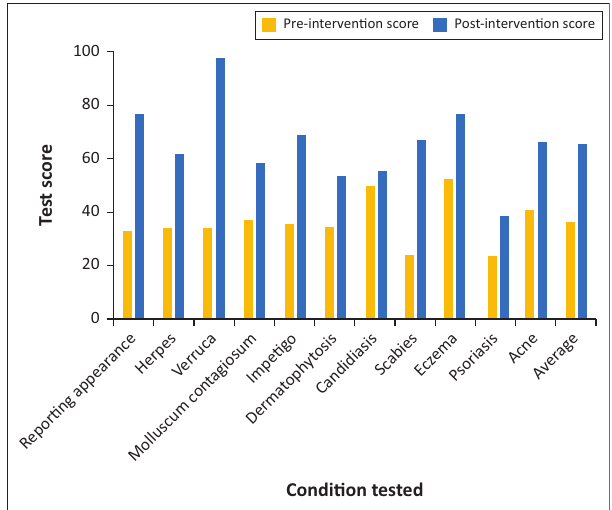
FIGURE 1: Breakdown of average performance by each of the 11